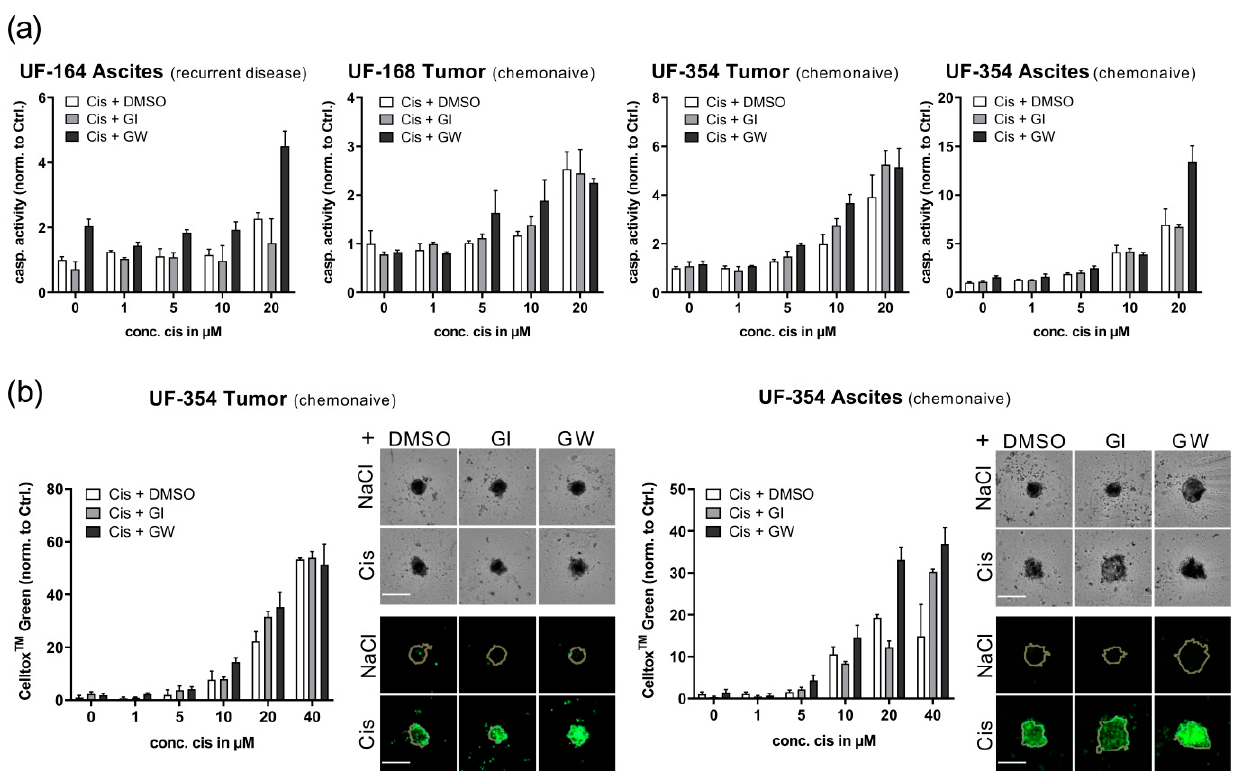
Figure 6. Translational application of multiplex workflow confirms the combinatorial effect of GW280264X and cisplatin in primary OvCa spheroids. Primary cells were isolated from tumor and ascites of three OvCa patients, seeded in ULA plates, and treated after four days of spheroid formation. ( a ) Caspase 3/7 activation 48 h after treatment revealed combinatorial effects by cisplatin treatment (Cis) and inhibition of ADAM17 with GW280264X (GW) compared with sole inhibition of ADAM10 by GI254023X (GI) in tumor-derived cells. DMSO was used as the solvent control. This effect was even more pronounced in ascites. ( b ) CellTox TM Green staining confirmed these combinatorial effects. Representative images show the best combined effect using 20 µ M cisplatin (cis). Upper panel: brightfield; Lower panel: CellTox TM Green. Orange line indicates spheroid area. Magnification 4 × . Scale: 250 µ m. Data are presented as mean + SD of three technical replicates. As for restricted patient material, no statistical analysis was performed using technical replicates.